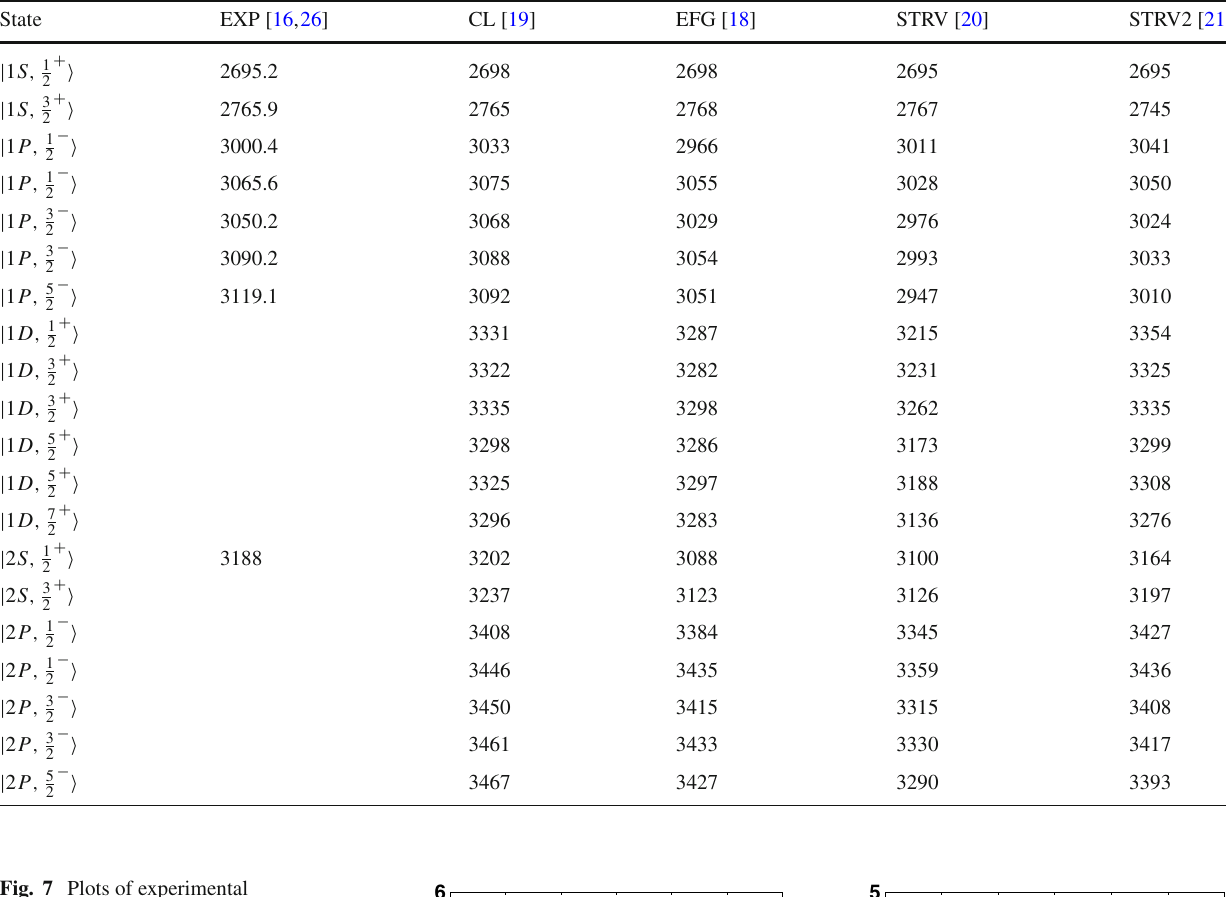
Table 5 The experimental and different model calculated values for (cid:4) c baryons with a bad diquark ( S qq = 1). Here, the constituent quark masses [17] we adopted to analyze experimental data as well as EFG calculations are given by Eq. (10)